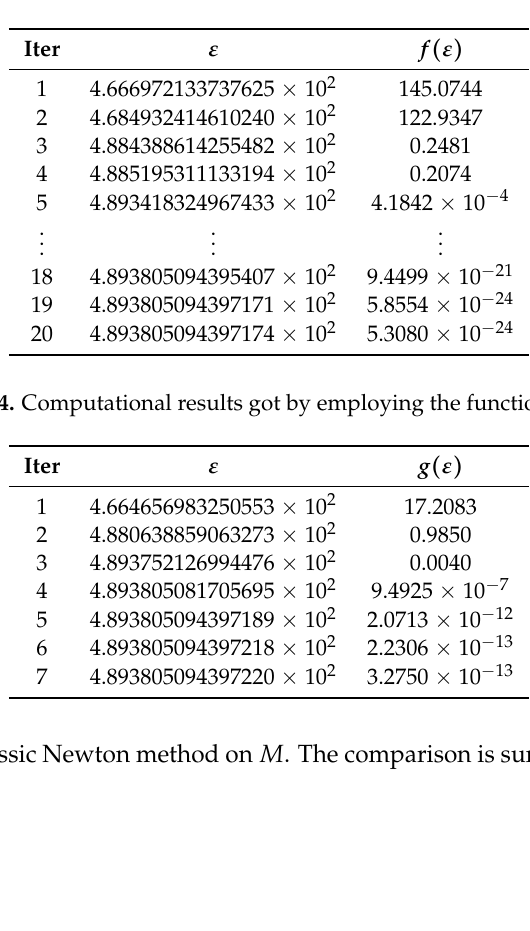
Table 3. Computational results obtained by coupling modified Newton method and bisection.